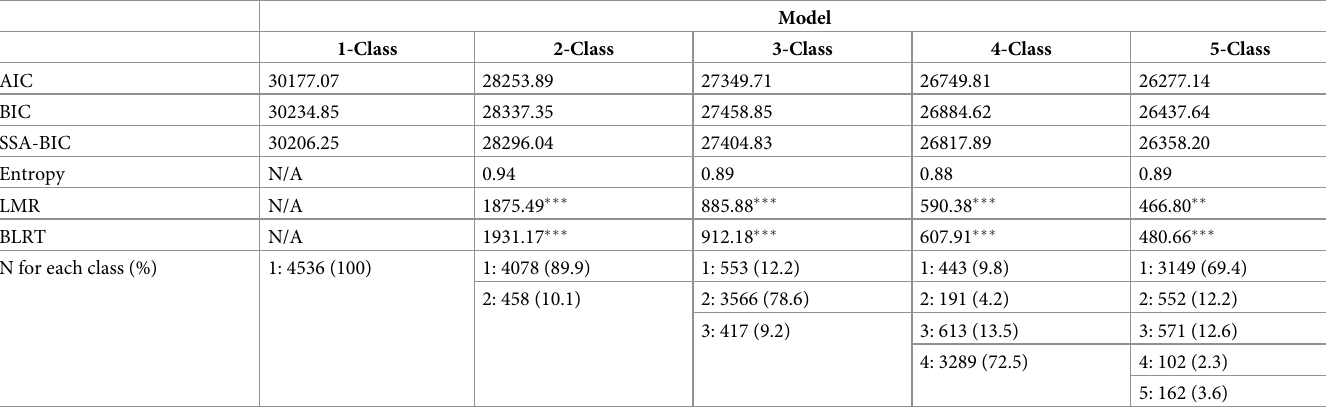
Table 3. LPA model selection criteria for victimization, connectedness with adults at home, and peer belonging among 4 th graders ( N =